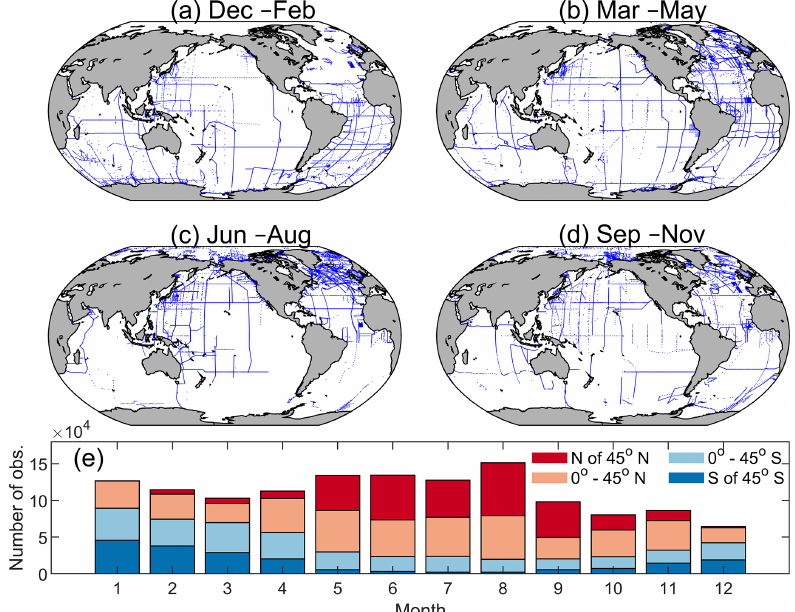
Figure 9. Distribution of data in GLODAPv2.2021 in (a) December–February, (b) March–May, (c) June–August, and (d) September– November, as well as (e) number of observations for each month in four latitude